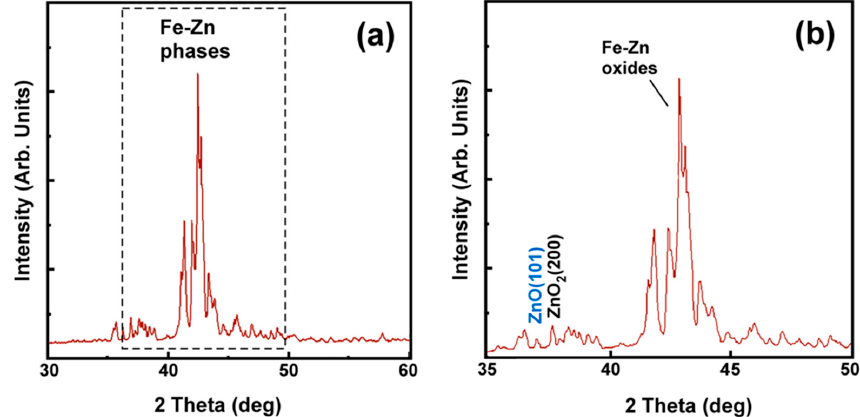
Figure 6. BB-XRD diffraction pattern ( a ) of the samples coated by pack cementation and ( b ) XRD pattern focusing on the framed area for the identification of the existing oxides. Peak identification was accomplished using the following PDF cards: 65-3411 and 65-0523 (ZnO), 76-1364 (ZnO 2 ), 48-0567 (Fe 0.76 Zn 0.24 O 1.165 ), 45-1184 (delta phase)